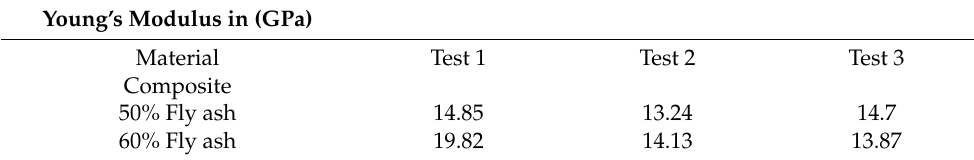
Table 5. Synthesis of compression mechanical test